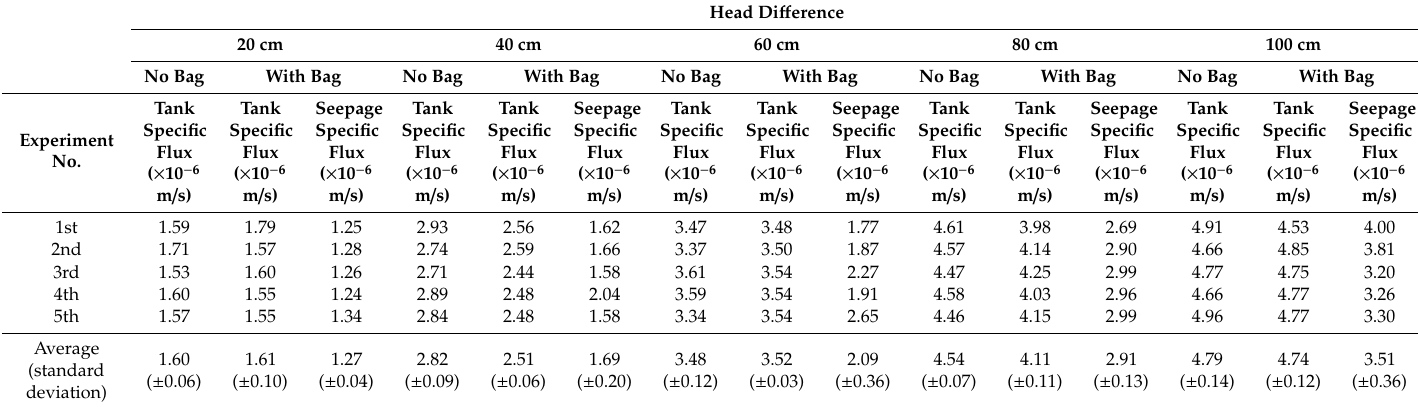
Table 2. Influx measurement experiment using the Type 1 collection bag.